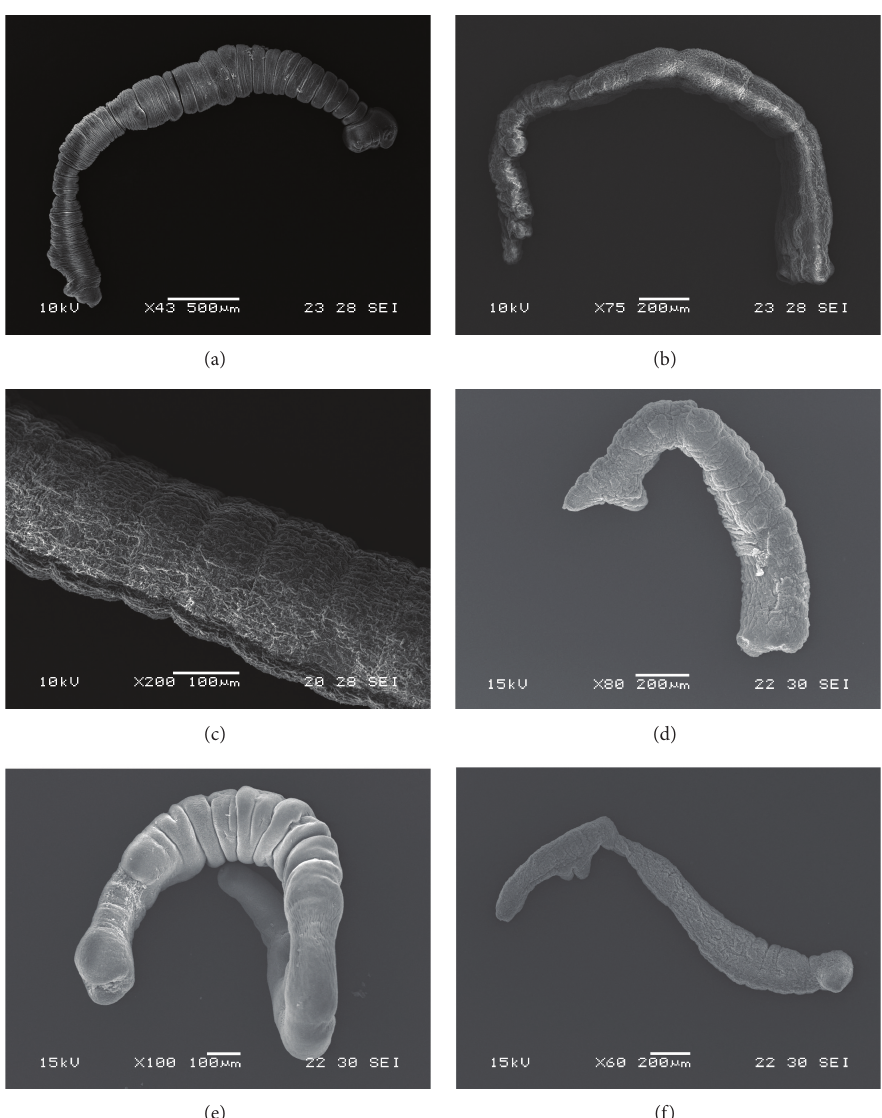
Figure 4: Scanning electron microscopy of Mesocestoides corti adult worms incubated in vitro with thymol. (a) Control adult worm (43x). (b) Adult worm after 15 min of incubation (250 𝜇 g/mL). Note the tegumental alterations (75x). (c) Partial view of a strobila. Observe the extensive erosion of the tegument (1h, 200 𝜇 g/mL, 200x). (d) Altered adult worm (1h, 250 𝜇 g/mL). The constrictions between proglottids became difficult to distinguish (80x). (e) Adult worm after 1h following incubation. Partial loss of microtriches (1h, 150 𝜇 g/mL, 100x). (f) Adult worm totally altered after overnight incubation (150 𝜇 g/mL,